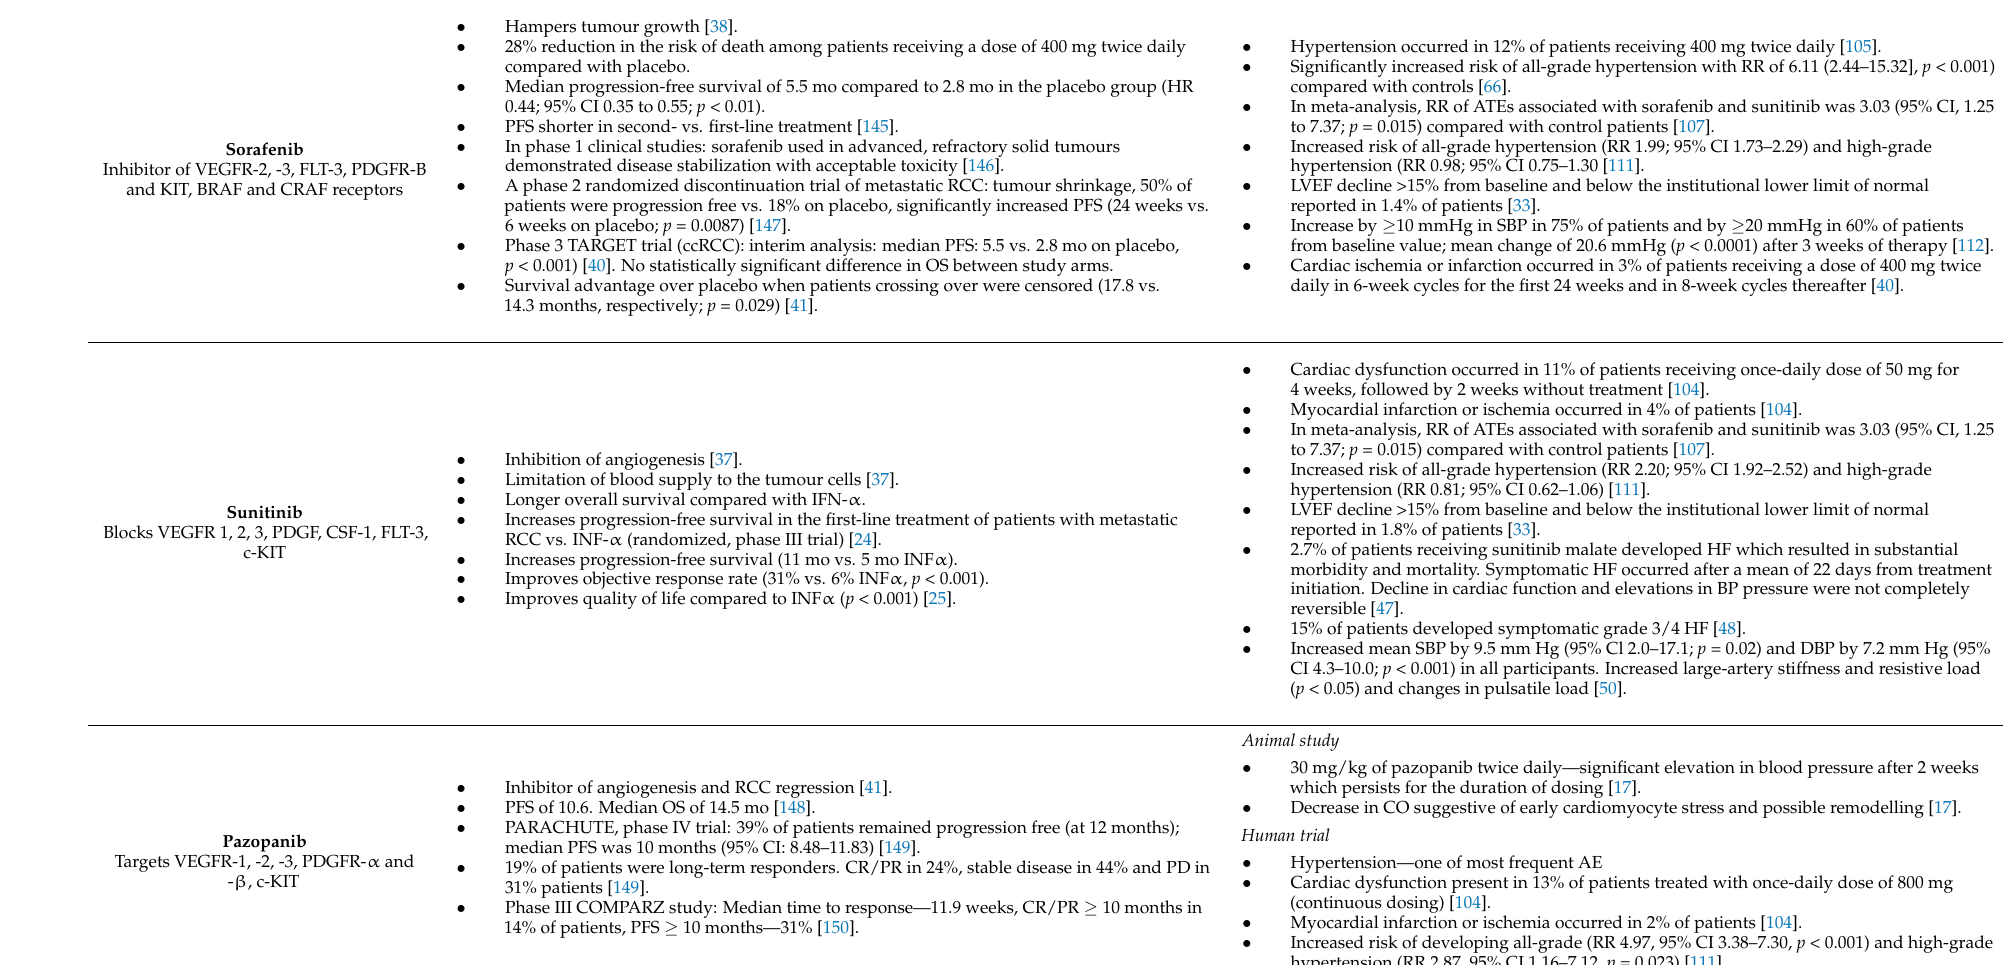
Table 2. The results of studies presenting benefits and cardiotoxicity risk related to VEGF TKIs. Name of Drug/Mechanism of